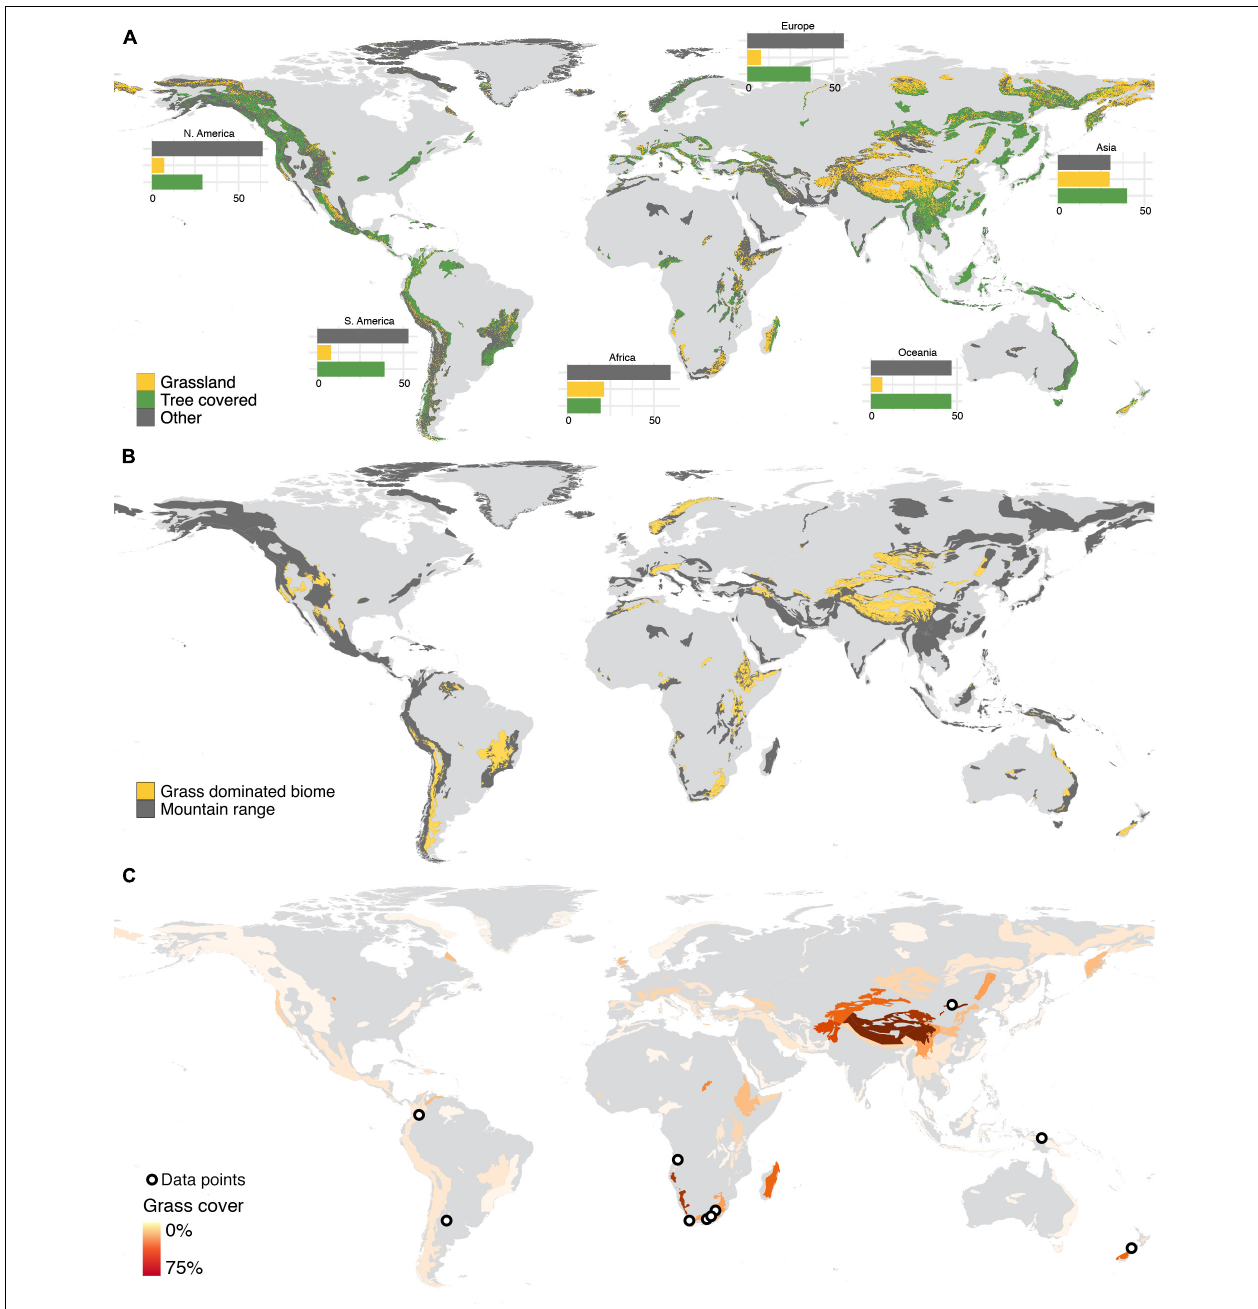
FIGURE 1 | Grassiness in the World’s mountains. (A) Proportion of area occupied by grasslands, forests, or other land cover categories in each mountain. (B) The spatial distribution of grass-dominated and co-dominated biomes in the World’s mountains. (C) Percentage of land in each mountain covered by grassland and data localities used in the elevation vs. C 3 -C 4 community change